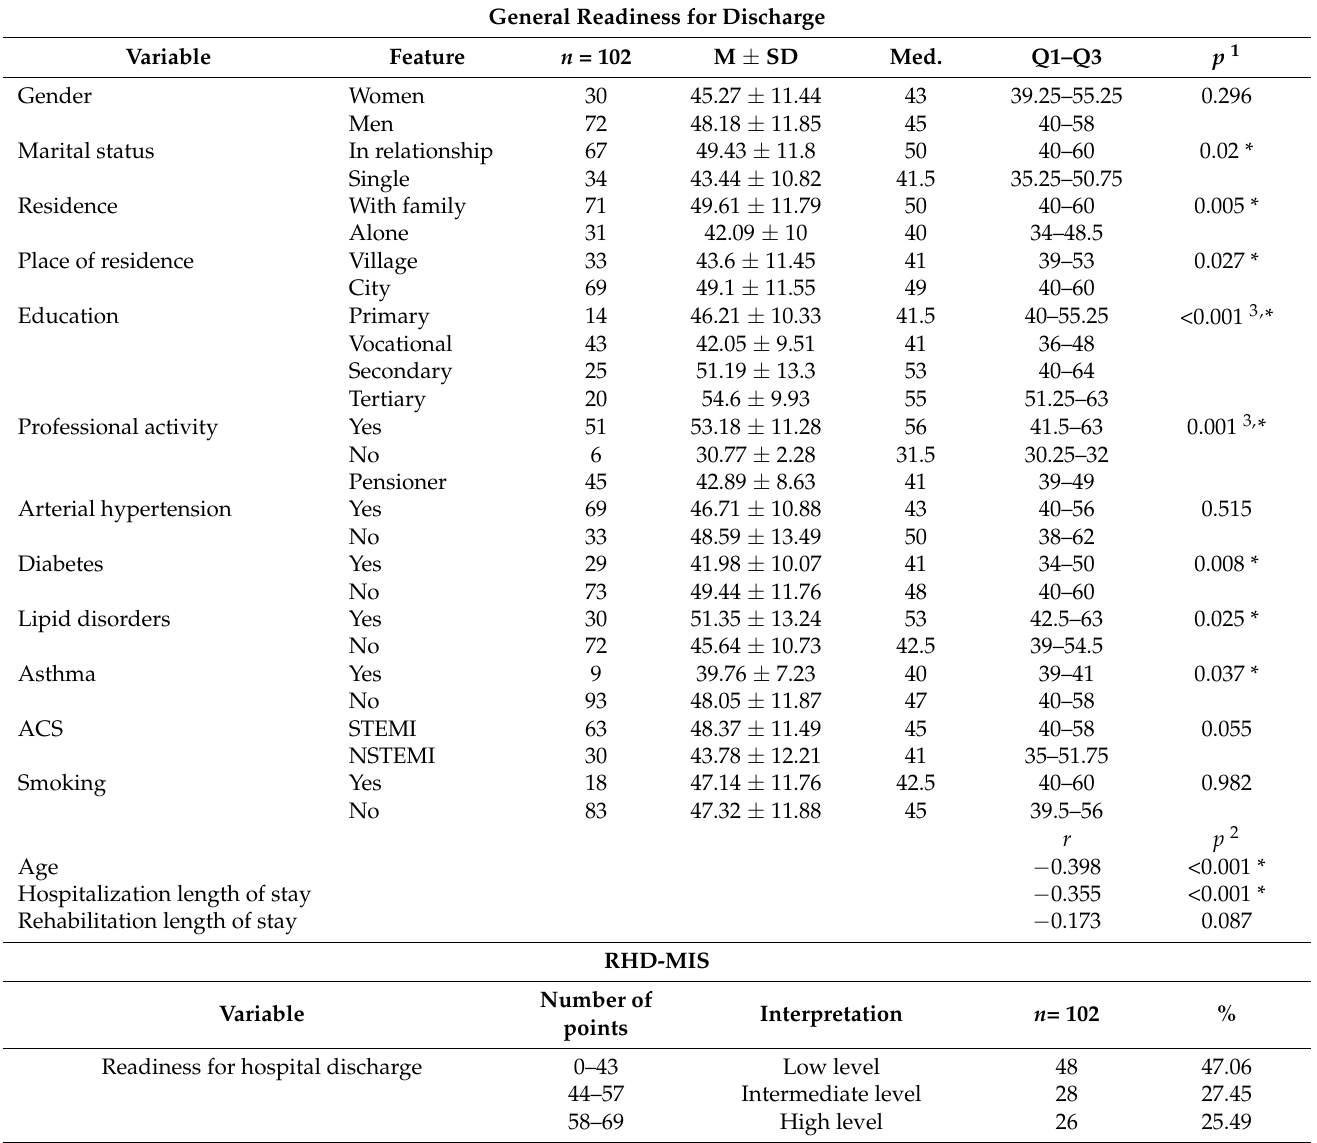
Table 2. Effects of socio-demographic and clinical variables on general readiness for hospital discharge in MI